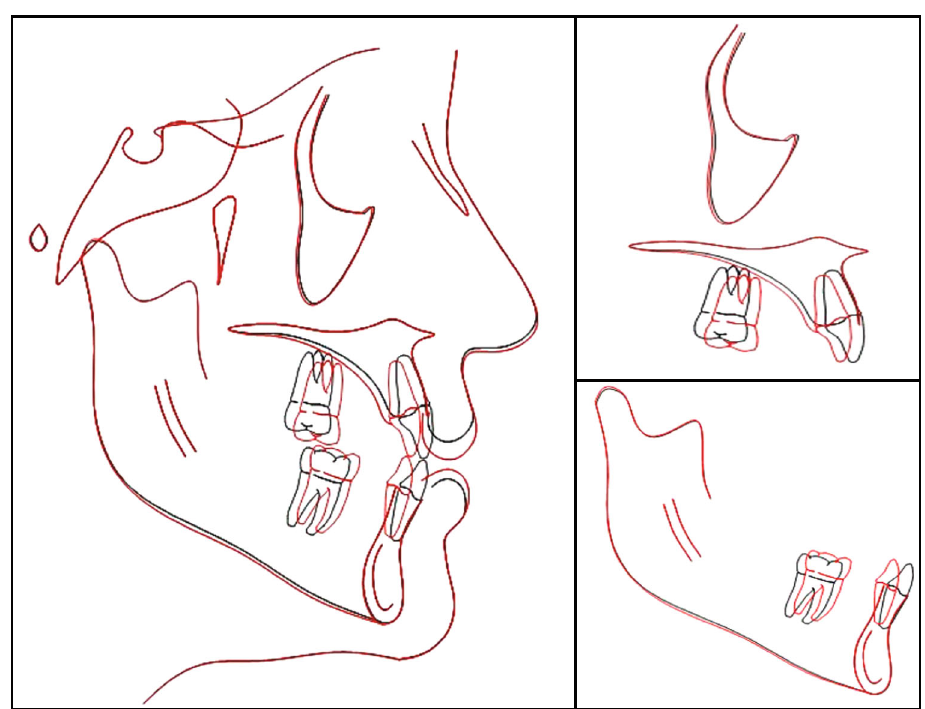
Figure 9: Posttreatment cephalometric superimposition. Black line: pretreatment. Red line: